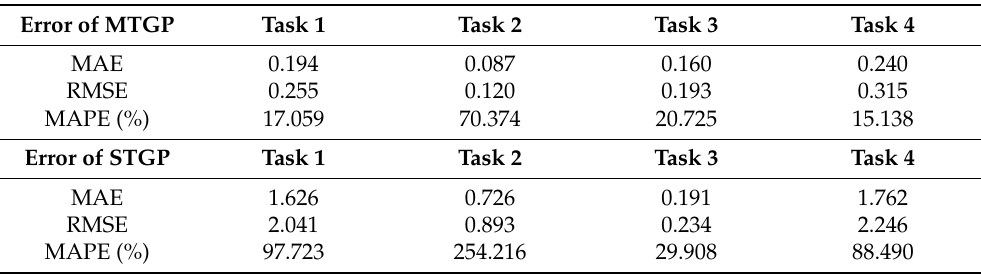
Table 1. Error results of MTGP and STGP for